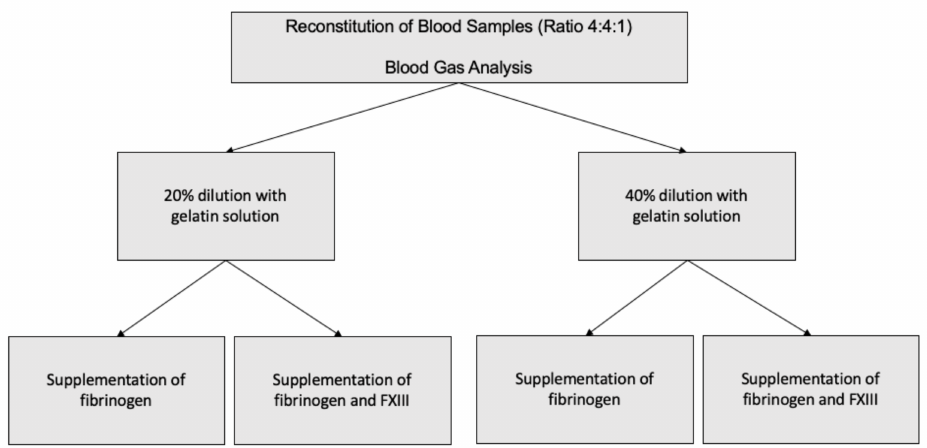
Figure 1. Visualization of the study